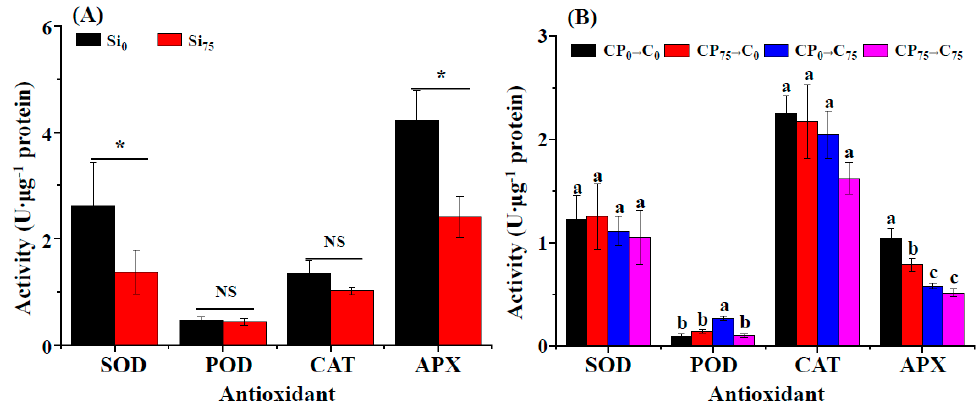
Figure 6. Antioxidant enzyme activities in leaves of poinsettia subjected to high ( A ) and low ( B ) temperature stresses. The asterisk and different letters besides error bars indicate significant differences according to Student’s t -test and Duncan’s test, respectively ( p ≤ 0.05). NS, non-significant; Si 0 , 0 mg ∙ L − 1 Si; Si 75 , 75 mg ∙ L − 1 Si; CP 0 → C 0 , 0 mg ∙ L − 1 Si during cutting propagation and cultivation; CP 75 → C 0 , 75 mg ∙ L − 1 Si during cutting propagation and 0 mg ∙ L − 1 Si during cultivation; CP 0 → C 75 , 0 mg ∙ L − 1 Si during cutting propagation and 75 mg ∙ L − 1 Si during cultivation; CP 75 → C 75 , 75